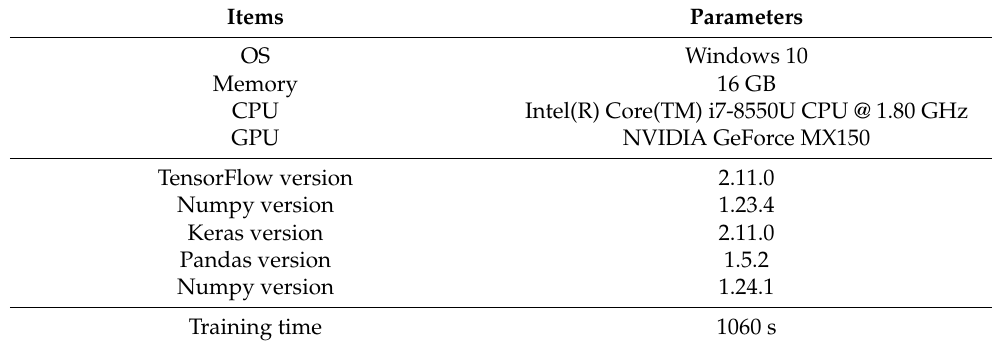
Table 1. Experimental